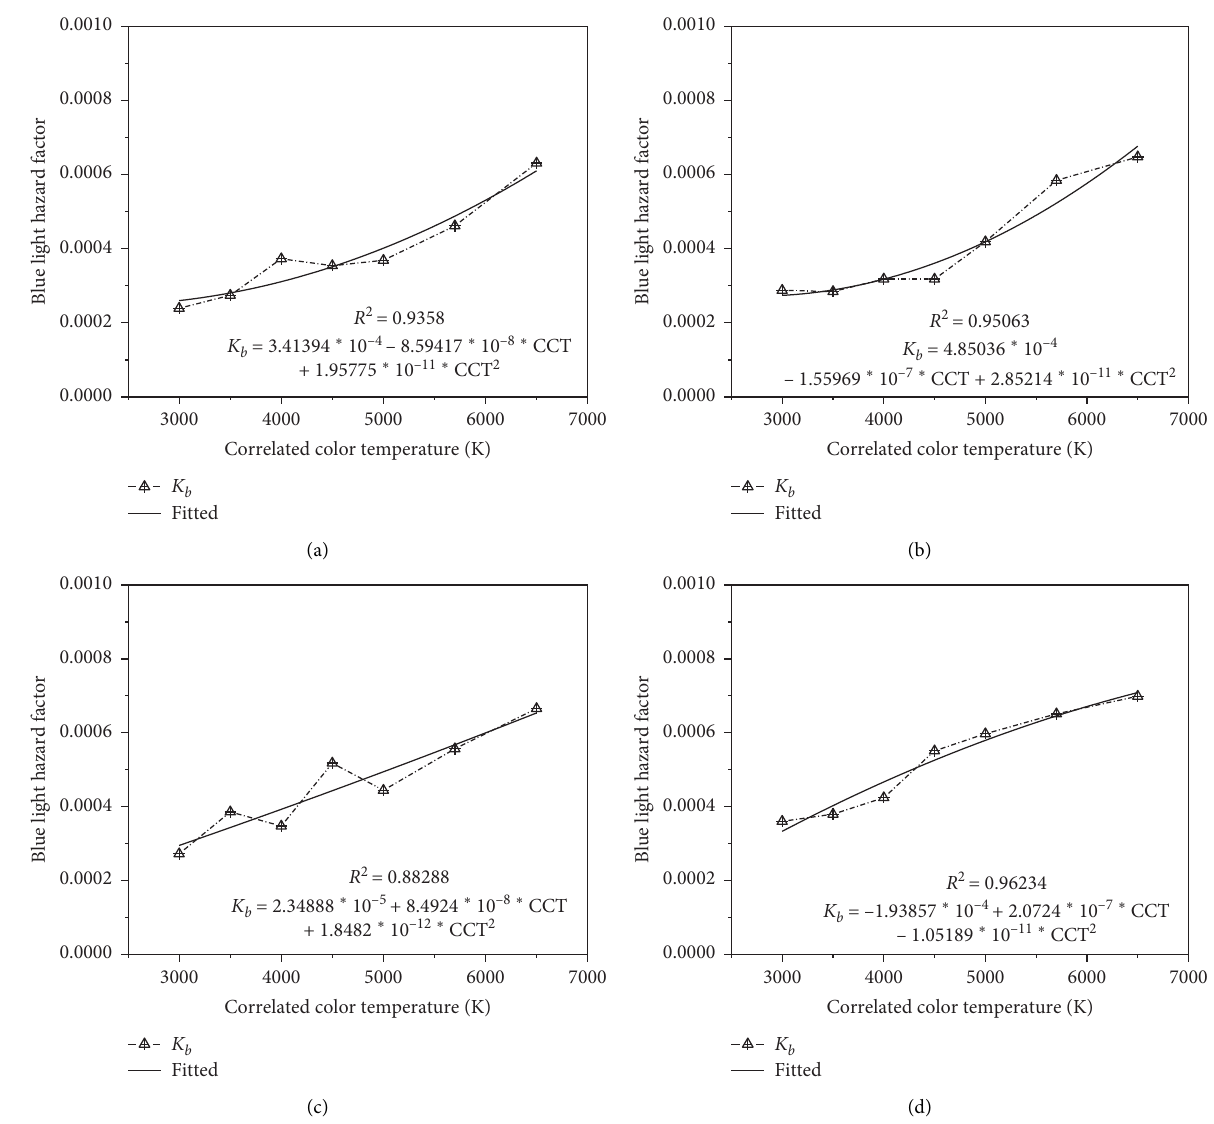
Figure 8: Blue light hazard factor. (a) CRI2012 � 65. (b) CRI2012 � 75. (c) CRI2012 � 85. (d) CRI2012 � 95.